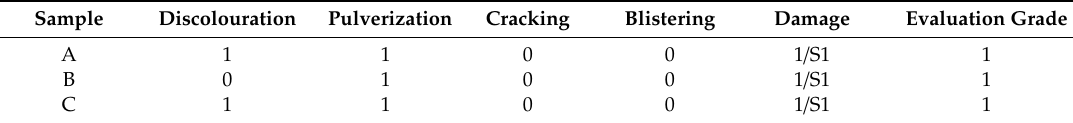
Table 3. The results of accelerated weather aging test (1000 h) for photocatalytic coating.